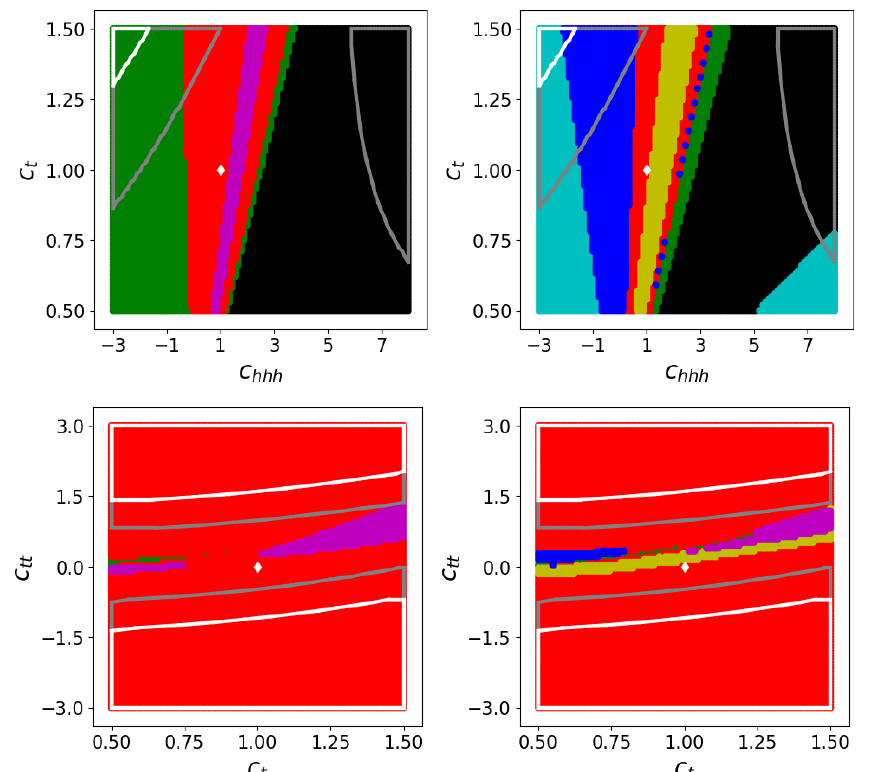
Figure 11 . Shape types produced by variations of c t versus c hhh (top) and c t versus c tt (bottom). Left: 4 clusters, right: 7 clusters. The areas outside the silver and white curves are regions where the total cross section exceeds 6 : 9 (cid:2) (cid:27) SM and 22 : 2 (cid:2) (cid:27) SM , respectively. These values are motivated p by the current ATLAS/CMS limits at s = 13 TeV [1, 2]. The red areas denote SM-like shapes. The full colour code is given in table